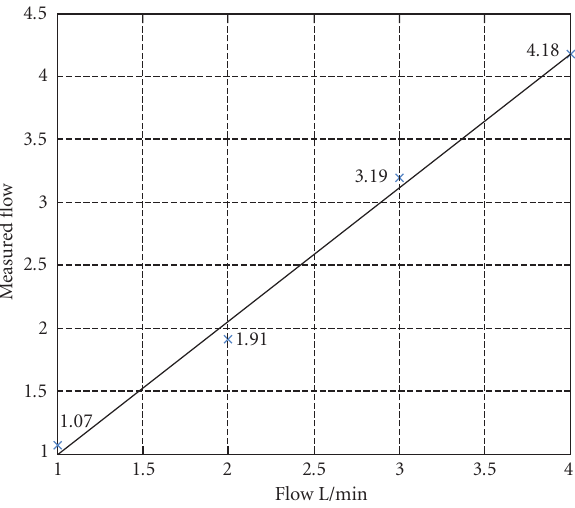
Figure 12: Ultrasound flow measurements ( Y -axis) compared to the magnetic flowmeter ones ( X -axis). The determination coe ffi - cient of the regression line is